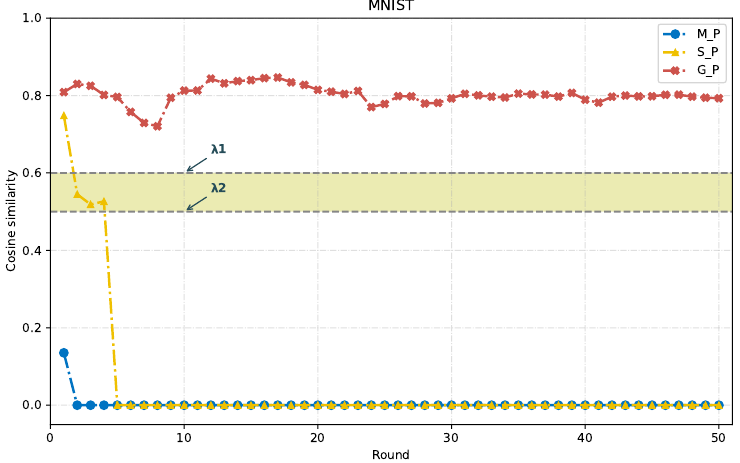
Figure 3. MDIFL judges the effect of malicious